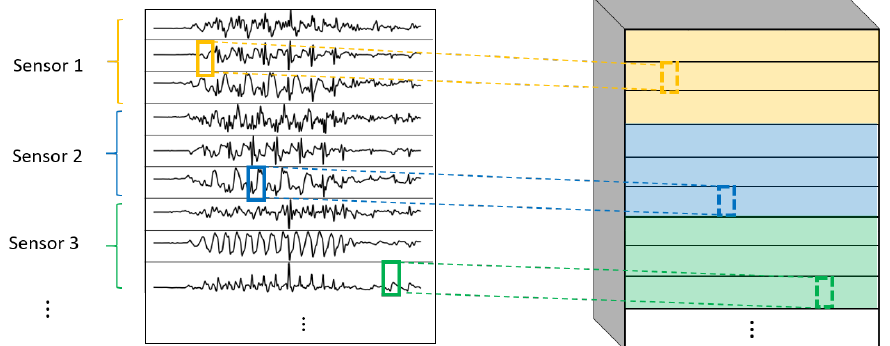
Figure 7. 1DCNN per sensor convolution logic.